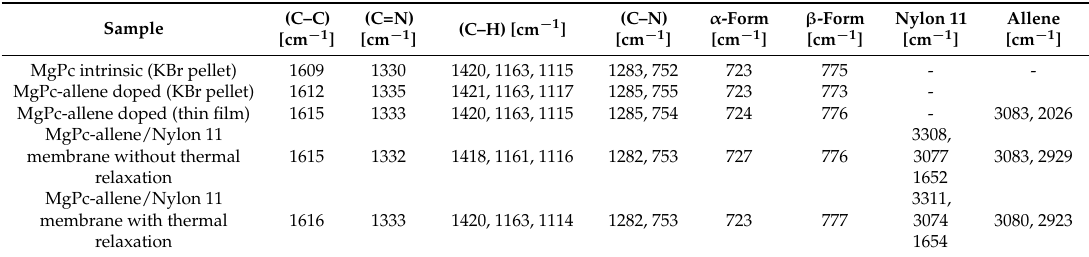
Table 1. Characteristic FT-IR signals for MgPc intrinsic, doped, and